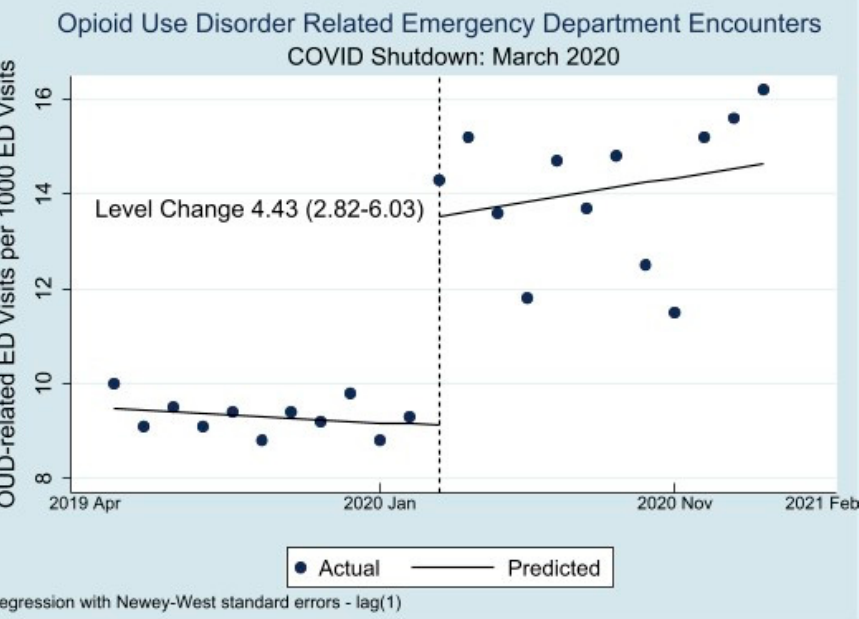
Figure 1. Interrupted Time Series of OUD-related LA County Emergency Department Visits by Month.